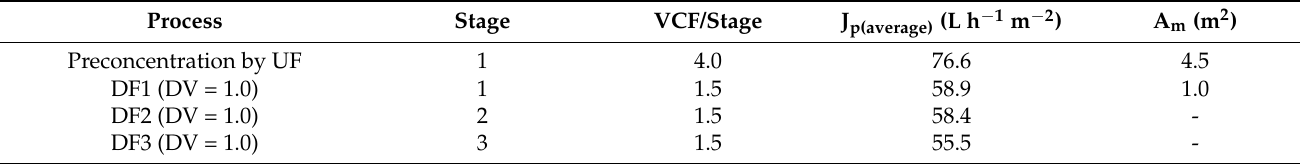
Table 3. Process parameters for q f = 450 L h − 1 of GCW or SCW; ∆ P = 2.0 bar; Qrec = 10 L min − 1